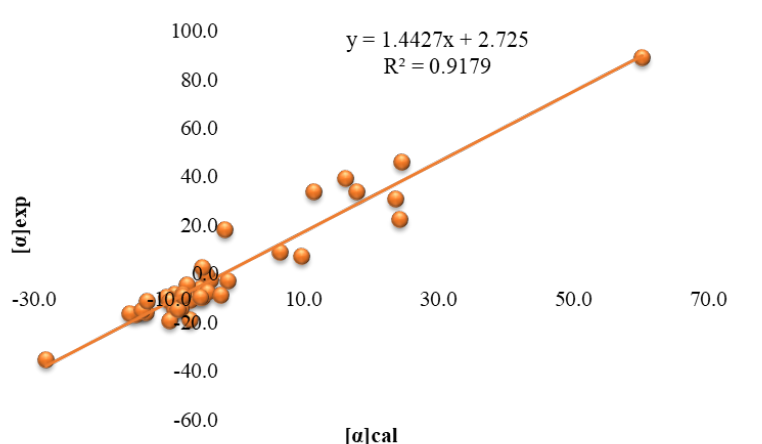
Figure 5. Linear relationship between experimentally determined [α]exp and calculated [α]cal op- tical rotation angle for different honey types. The weakest linear dependence was observed for oak honey. The samples forming this class of honey could be divided into two groups according to the size of the calculated angle. For samples ok15 – ok21, the calculated angle was larger than the experimentally